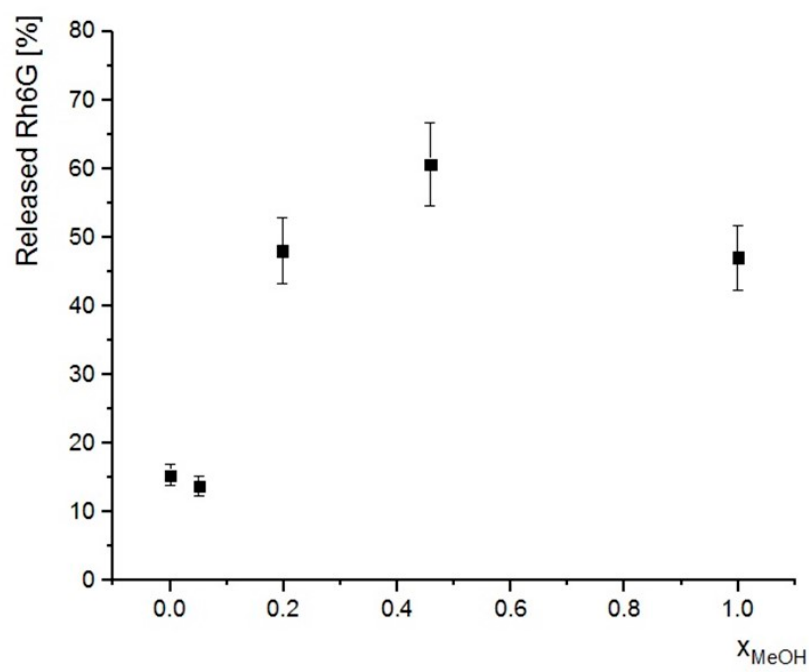
Figure 5. Release of Rh6G adsorbed in SCMS-PNIPAM(4) to water / methanol mixtures of various